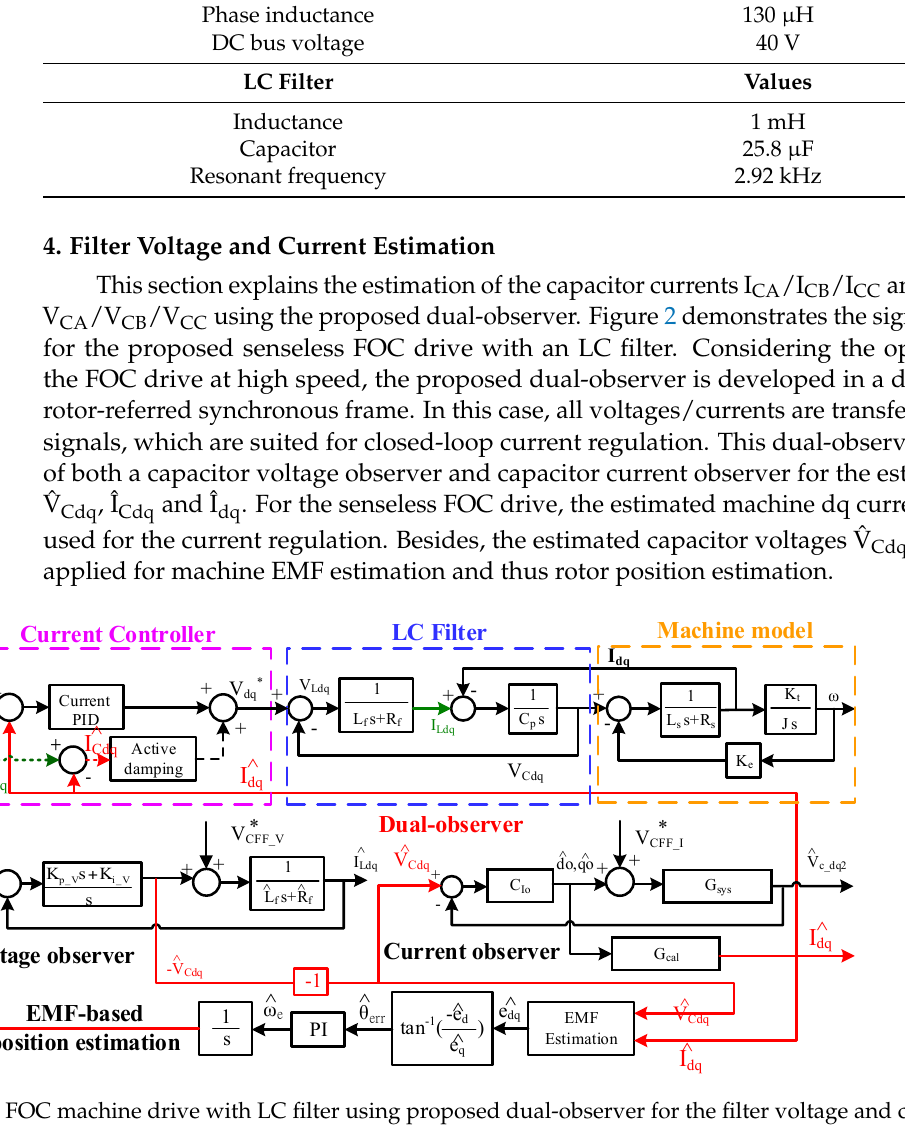
Figure 2. Illustration of FOC machine drive with LC filter using proposed dual-observer for the filter voltage and current estimation.